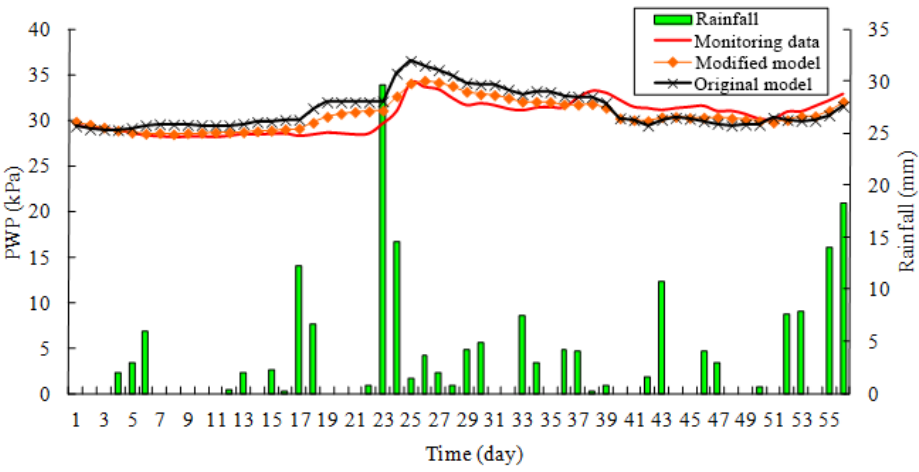
Figure 10. Estimation of the PWP using the original tank model and our modified tank model (snowmelt + time lag 1 + 2) during summer (7 July–31 August 2009).